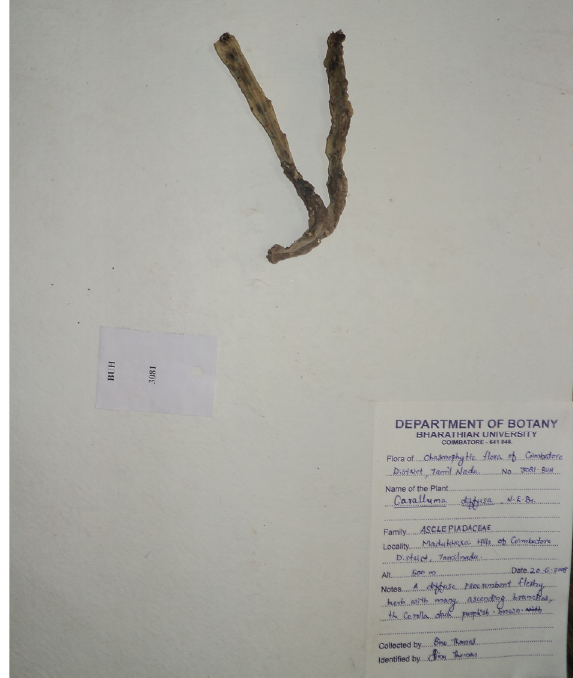
Figure 1. Herbarium of Caralluma